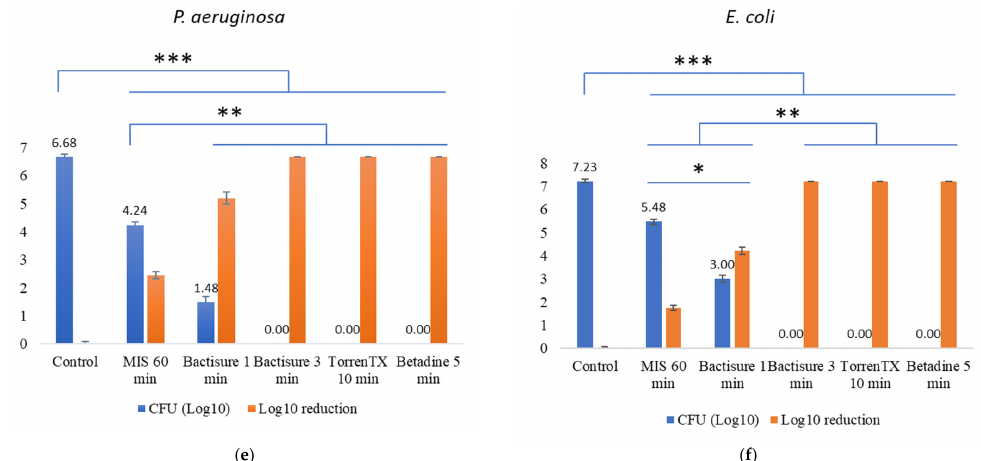
Figure 2. CFU (Log 10 ) and CFU log 10 reduction in 3-day-old bacterial biofilm cells for S. epidermidis ( a ), S. aureus ( b ), A. baumannii ( c ), S. pyogenes ( d ), P. aeruginosa ( e ), and E. coli ( f ) following treatment with Betadine, Bactisure, TorrenTX, and MIS at in-use concentration and contact time in the pres- ence of 5% BCS as biological soil. Error bar represents standard deviation from CFU Log 10 of the six replicates in each antiseptic test. * p < 0.05, ** p < 0.01, *** p < 0.001. Although TorrenTX with a 10 min contact time effectively killed all the Gram-nega- tive biofilm bacteria— E. coli , P. aeruginosa , and A. baumannii —it could not completely kill all the Gram-positive biofilm cells, with S. epidermidis being the most resilient. TorrenTX reduced the titre of S. aureus and S. pyogenes over 4 Log 10 . MIS resulted in 3 Log 10 reduction in A. baumannii, S. aureus, and S. pyogenes, but only resulted in over 2 Log 10 reduction in P. aeruginosa and less than 2 Log 10 reduction in S. epidermidis and E. coli .